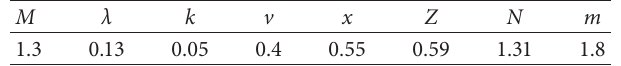
Figure 12: The physical meaning of parameters ξ . Table 5: Model parameter